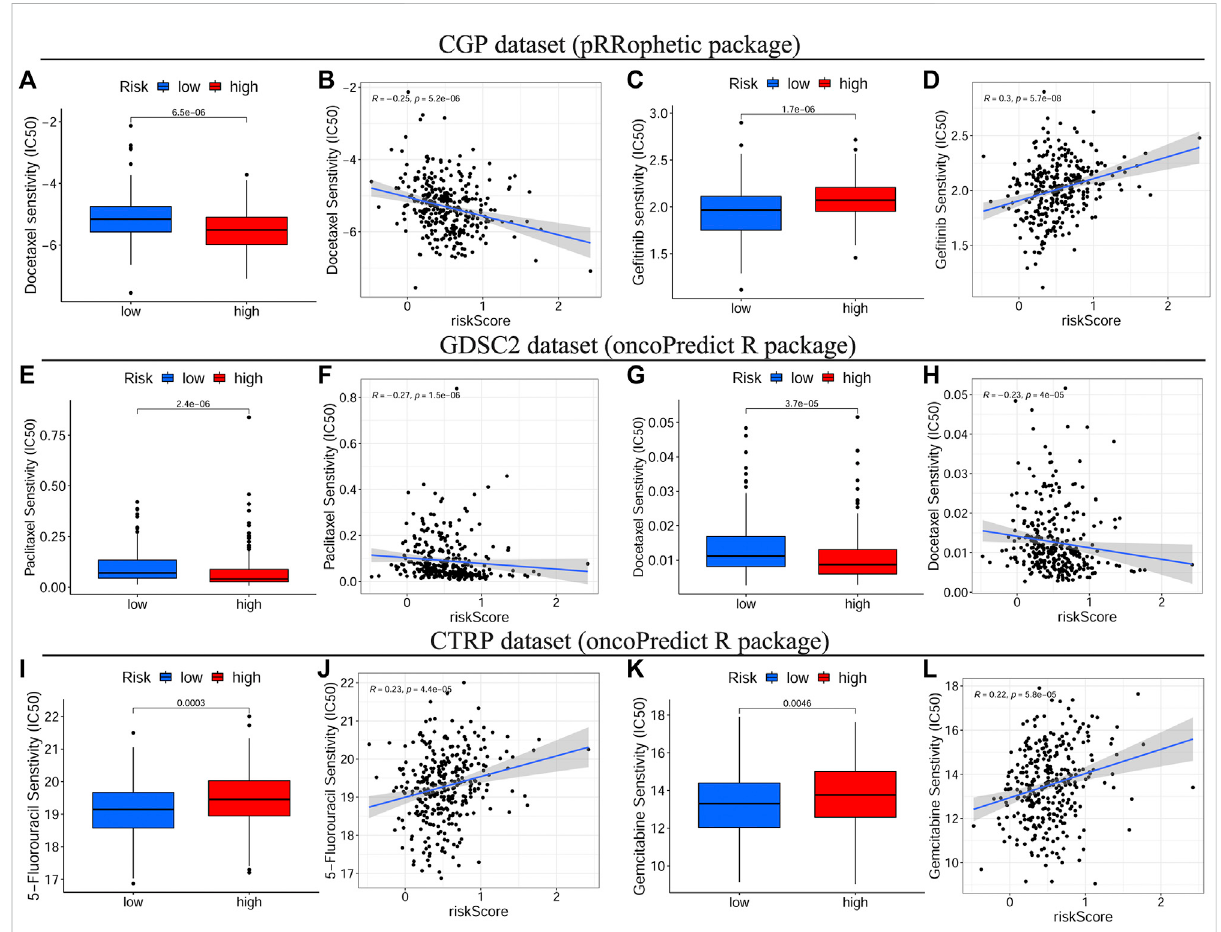
FIGURE 8 Drug sensitivity analyses on basis of TCGA cohort. The IC50 of some selected chemotherapeutic drugs, including CGP/GDSC2-derived Docetaxel (A – G) ,CGP-derivedGe fi tinib (C) ,GDSC2-derivedPaclitaxel (E) andCTRP-deriveddrugs,5-FluorouracilandGemcitabine (I,K) indifferent risk subgroups. The correlations between the risk score and some selected chemotherapeutic drugs, including CGP/GDSC2-derived Docetaxel (B – H) , CGP-derived Ge fi tinib (D) , GDSC2-derived Paclitaxel (F) and CTRP-derived drugs, 5-Fluorouracil and Gemcitabine (J,L) . TCGA,